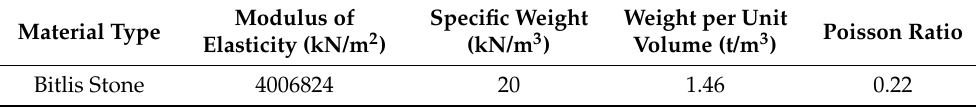
Table 2. Material properties considered for Bitlis stone used in minarets.